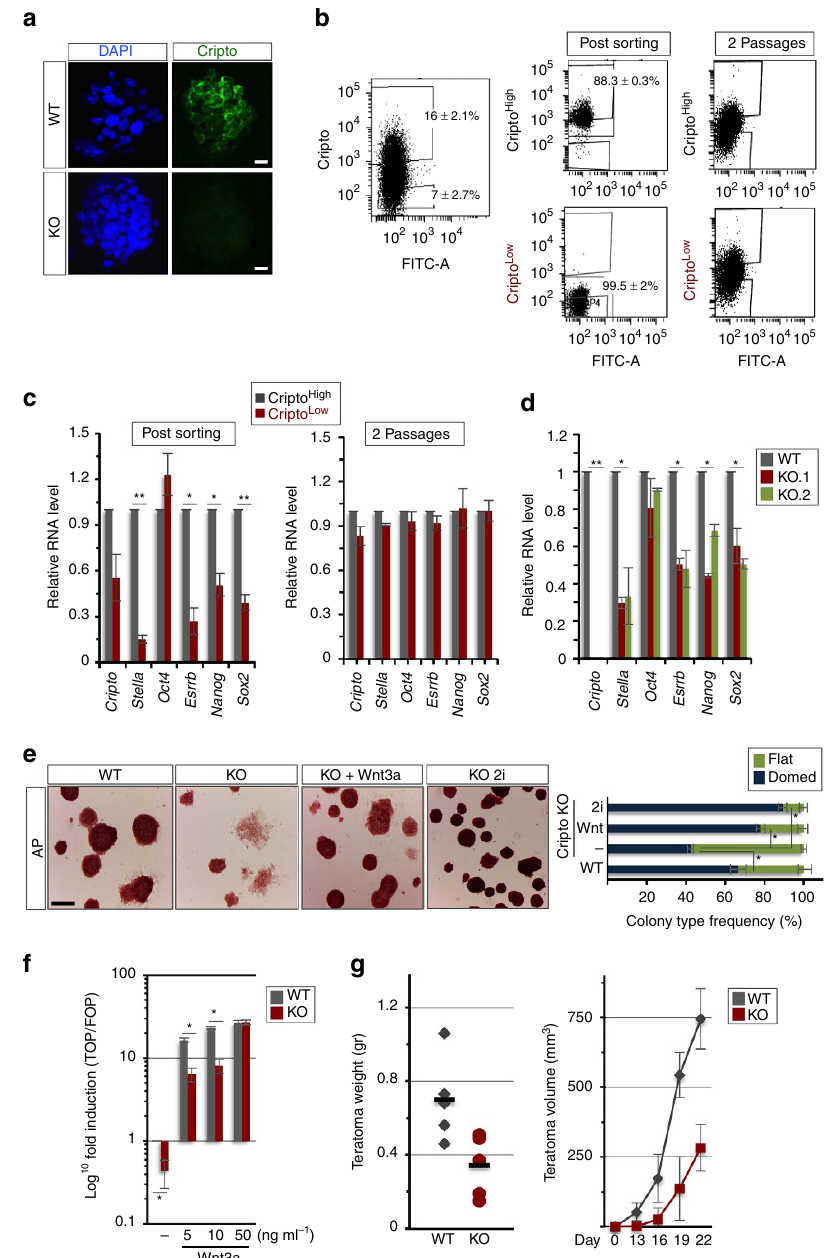
Figure 2 | Cripto sustains mESC self-renewal by modulating canonical Wnt signalling. ( a ) Immunofluorescence of Cripto on non-permeabilized WTand Cripto KO ESCs. Nuclei were stained with 4,6-diamidino-2-phenylindole (DAPI). Scale bar, 75 m m. ( b ) FACS-based separation of Cripto High and Cripto Low in serum/LIF mESCs. Data are mean ± s.e.m. ( n ¼ 3). ( c ) qPCR of Cripto and pluripotency genes’ expression on Cripto High and Cripto Low cells immediately after sorting and after two passages in culture. Relative RNA level was normalized to Gapdh ; data are mean ± s.e.m. ( n ¼ 3; * P o 0.01 and ** P o 0.005). ( d ) qPCR of pluripotency genes’ expression in WTand two independent Cripto KO ESC clones (KO.1 and KO.2) in serum/LIF culture conditions. Relative RNA level was normalized to Gapdh ; data are mean ± s.e.m. ( n ¼ 3; * P o 0.01 and ** P o 0.005). ( e ) Representative pictures (scale bar, 100 m m) of AP- stained and colony-type frequency (domed versus flat) of colonies generated from WT, Cripto KO, KO þ Wnt3a (50ngml (cid:2) 1 ) and KO 2i ESCs, at day 6 after plating ( B 100 colonies scored per condition). ( f ) TOP flash reporter activation in WTand Cripto KO ESCs in baseline conditions and following Wnt3a stimulation at indicated concentrations. Data are mean ± s.e.m. ( n ¼ 3); * P o 0.01. ( g ) Effect of Cripto depletion on teratomas formation. Quantitative analysis of tissue weights (left panel) and temporal kinetic analysis (right panel) of teratomas growth (volume, mm 3 ). Data are mean ± s.e.m. (five mice per group).